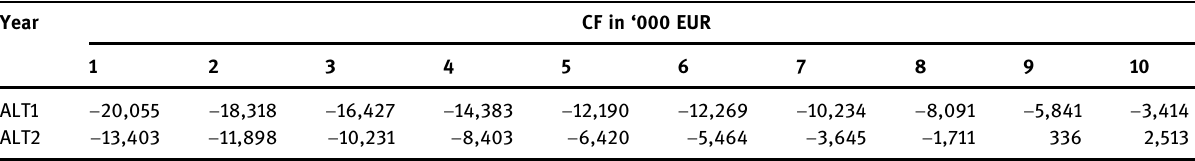
Table 5: Accumulated discounted CF over the lifetime of the